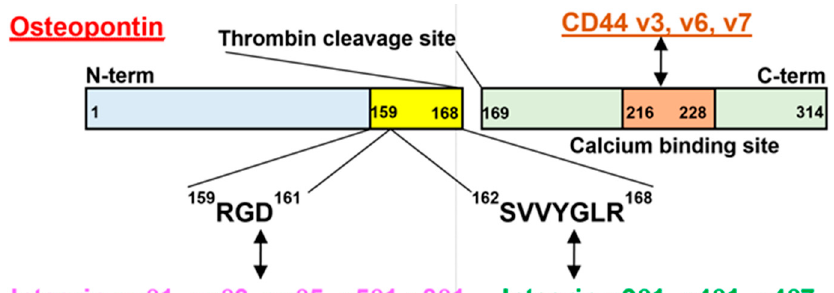
Figure 1. Structure of osteopontin (OPN). Amino acid (a.a.) sequences/domains involved in the receptor binding are shown. The α v β 1, α v β 3, α v β 5, α 5 β 1, and α 8 β 1 integrins bind to the RGD (159 – 161 a.a.) motif, while the α 9 β 1, α 4 β 1, and α 4 β 7 integrins bind to the SVVYGLR (162 – 168 a.a.) motif of OPN. The CD44v3, v6, and v7 bind to the OPN via its C-terminus fragment (169 – 300 a.a.) including calcium binding site (216 – 228 a.a.).